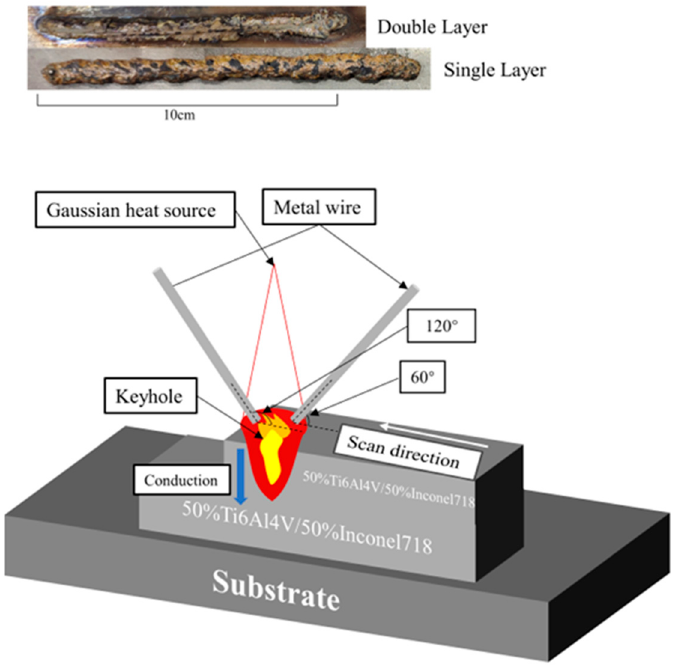
Figure 2. Sample diagram and print process diagram.